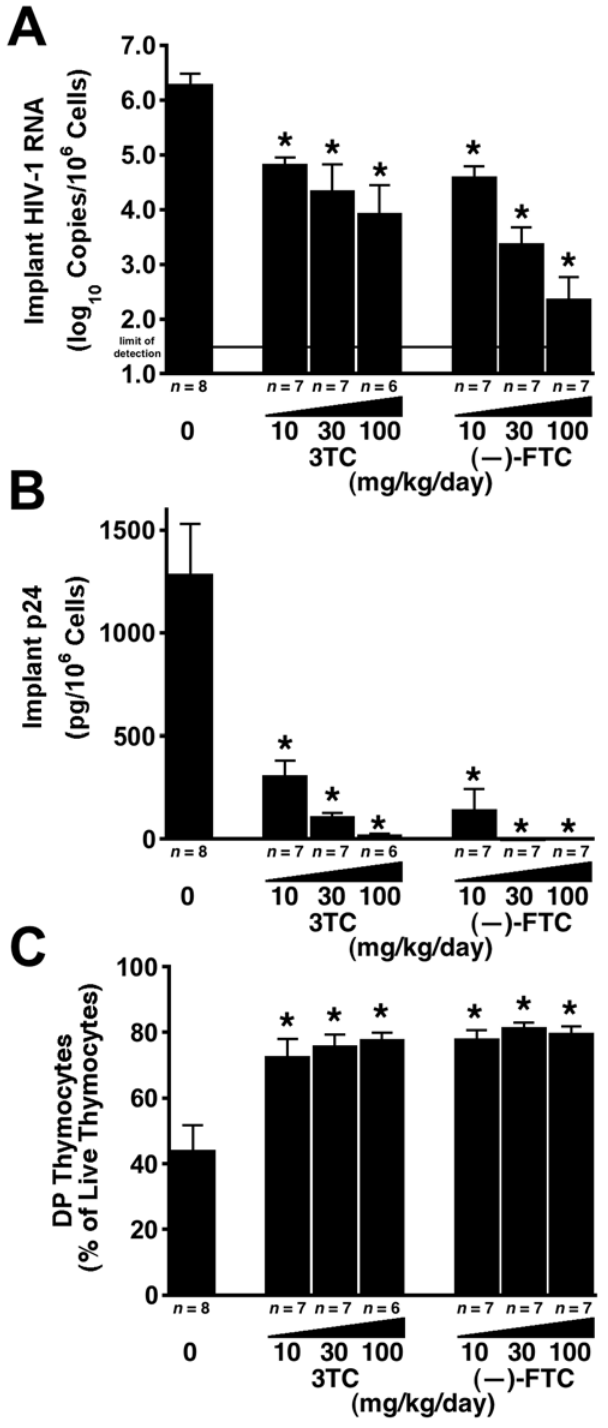
Figure 4. (–)-FTC is more potent than 3TC against HIV-1 NL4-3 in SCID-hu Thy/Liv mice. Mice were treated by twice-daily oral gavage with 3TC or (–)-FTC at 10, 30, and 100 mg/kg per day beginning on day –1. Antiviral efficacy was assessed by determining HIV-1 RNA (A) and p24 (B), and thymocyte protection was assessed by percentage of DP thymocytes (C) (means 6 SEM). *p # 0.05, compared with untreated mice for the number of mice indicated under each bar.